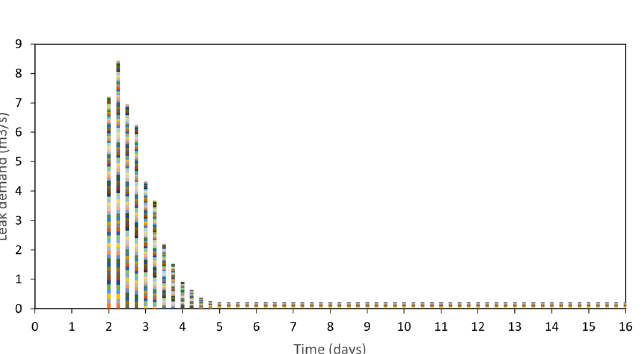
Figure 8. A stacked column chart of leak demand (m3/s) for damaged WDN components caused by a 5.5 M earthquake at Location 1 with RS2. Each coloured block in the stacked column represents a WDN